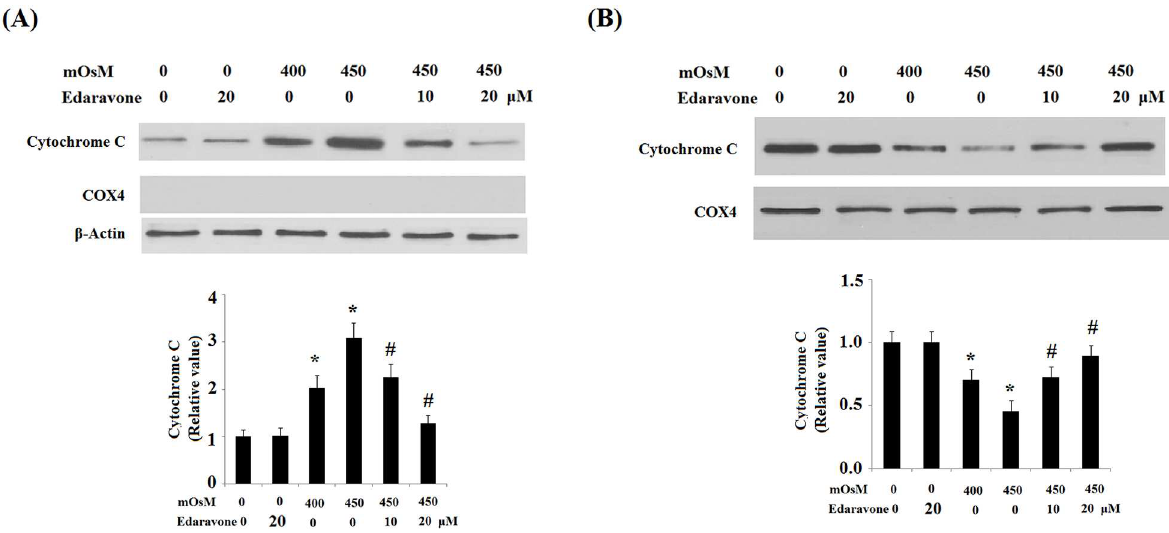
Fig 6. Effects of edaravone on cytosol cytochrome C releaseas measuredby western blot analysis. Results indicate that edaravone treatment attenuateshyperosmotic exposure(400–450mOsM)-induced releaseof cytochrome C. (A) Cytosolicfractions; (B) Mitochondrial fractions (ANOVA: * , P < 0.001vs. non-treatment control; #, P < 0.001vs. 450 mOsM treated group).